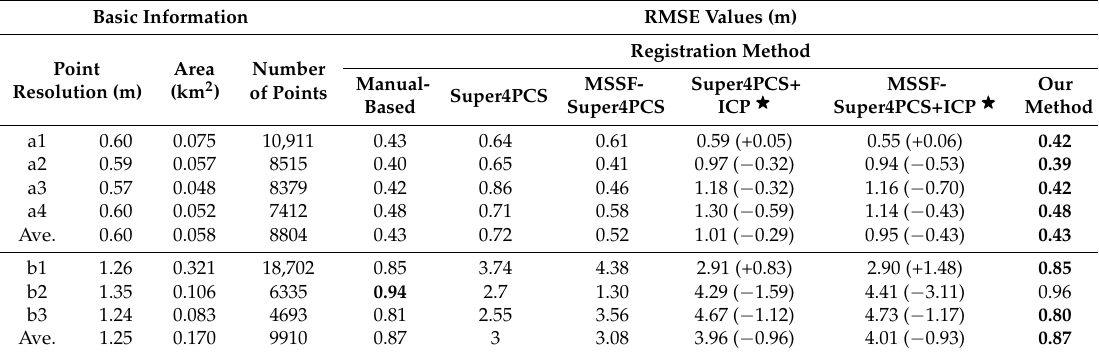
Table 3. RMSE values of the distances between the registered temporal TLS surveys by the different methods.